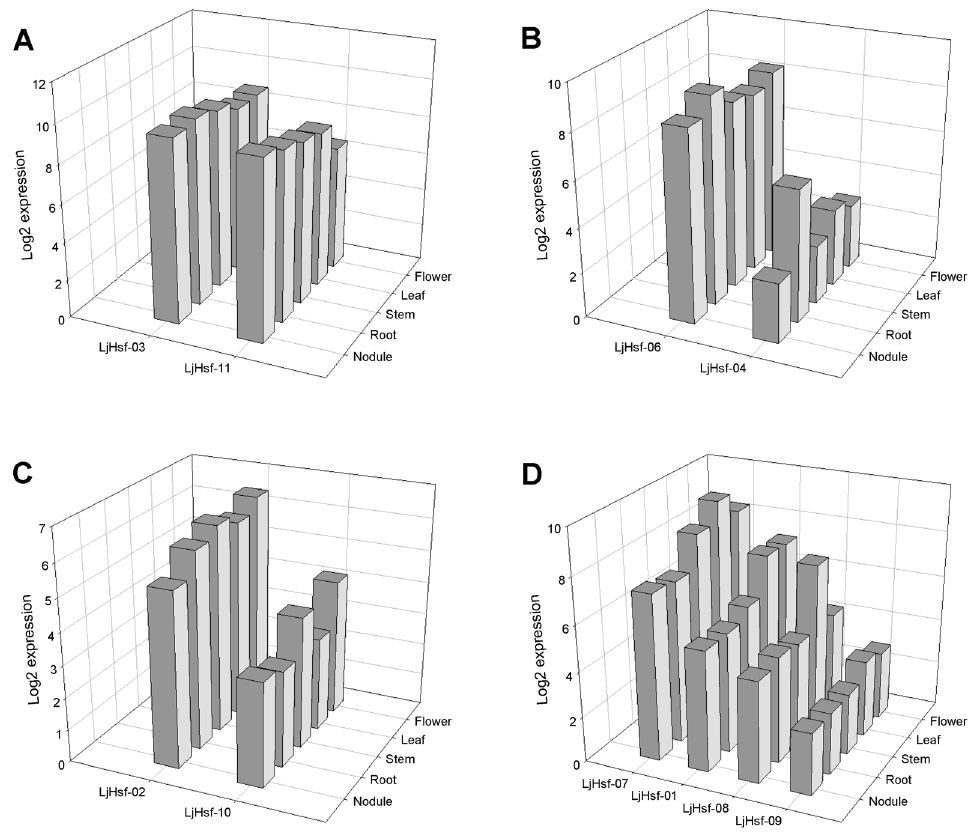
Figure 7. L.japonicus Hsf genes expression in various plant tissues. The type of tissue (nodule, root, stem, leaf and flower) and the gene name are shown on the y-axis and x-axis, respectively. Hierarchical clustering based on average log signal values in various tissues grouped 10 of the L. japonicus Hsf genes into four types (A–D).